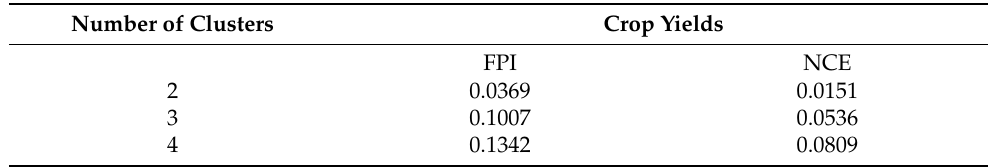
Table 3. Values of FPI and NCE based on standardized crop yields over seven years for the delineation of 2, 3, and 4 zones. Number of Clusters Crop Yields FPI NCE 2 0.0369 0.0151 3 0.1007 0.0536 4 0.1342 0.0809 FPI (fuzziness performance index), NCE (normalized classification entropy).